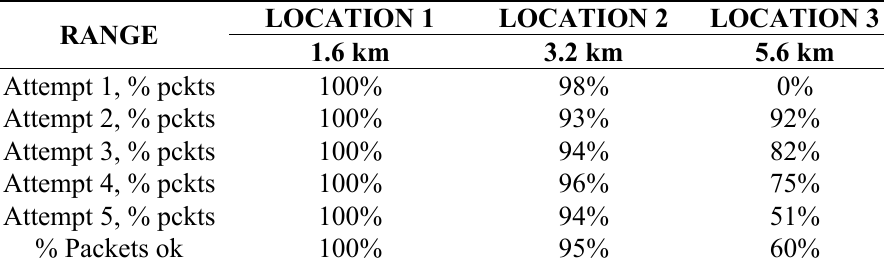
Table 4. Results of the communications